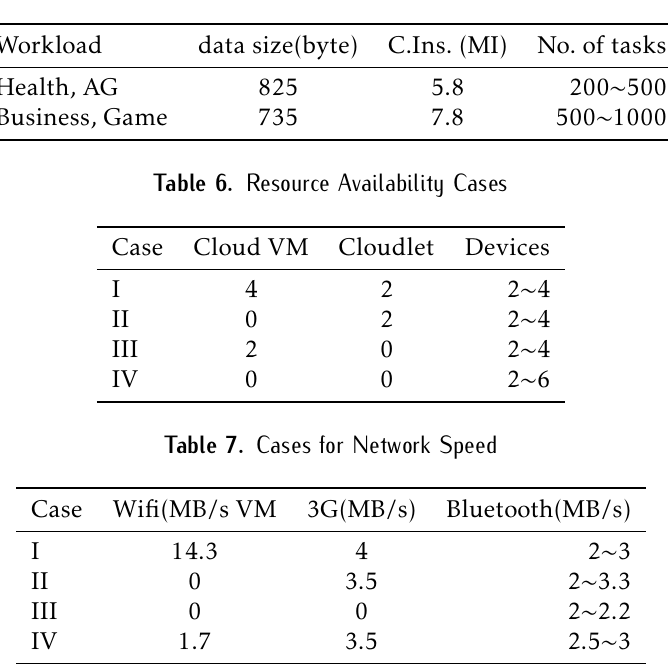
Table 5. Workload Analysis